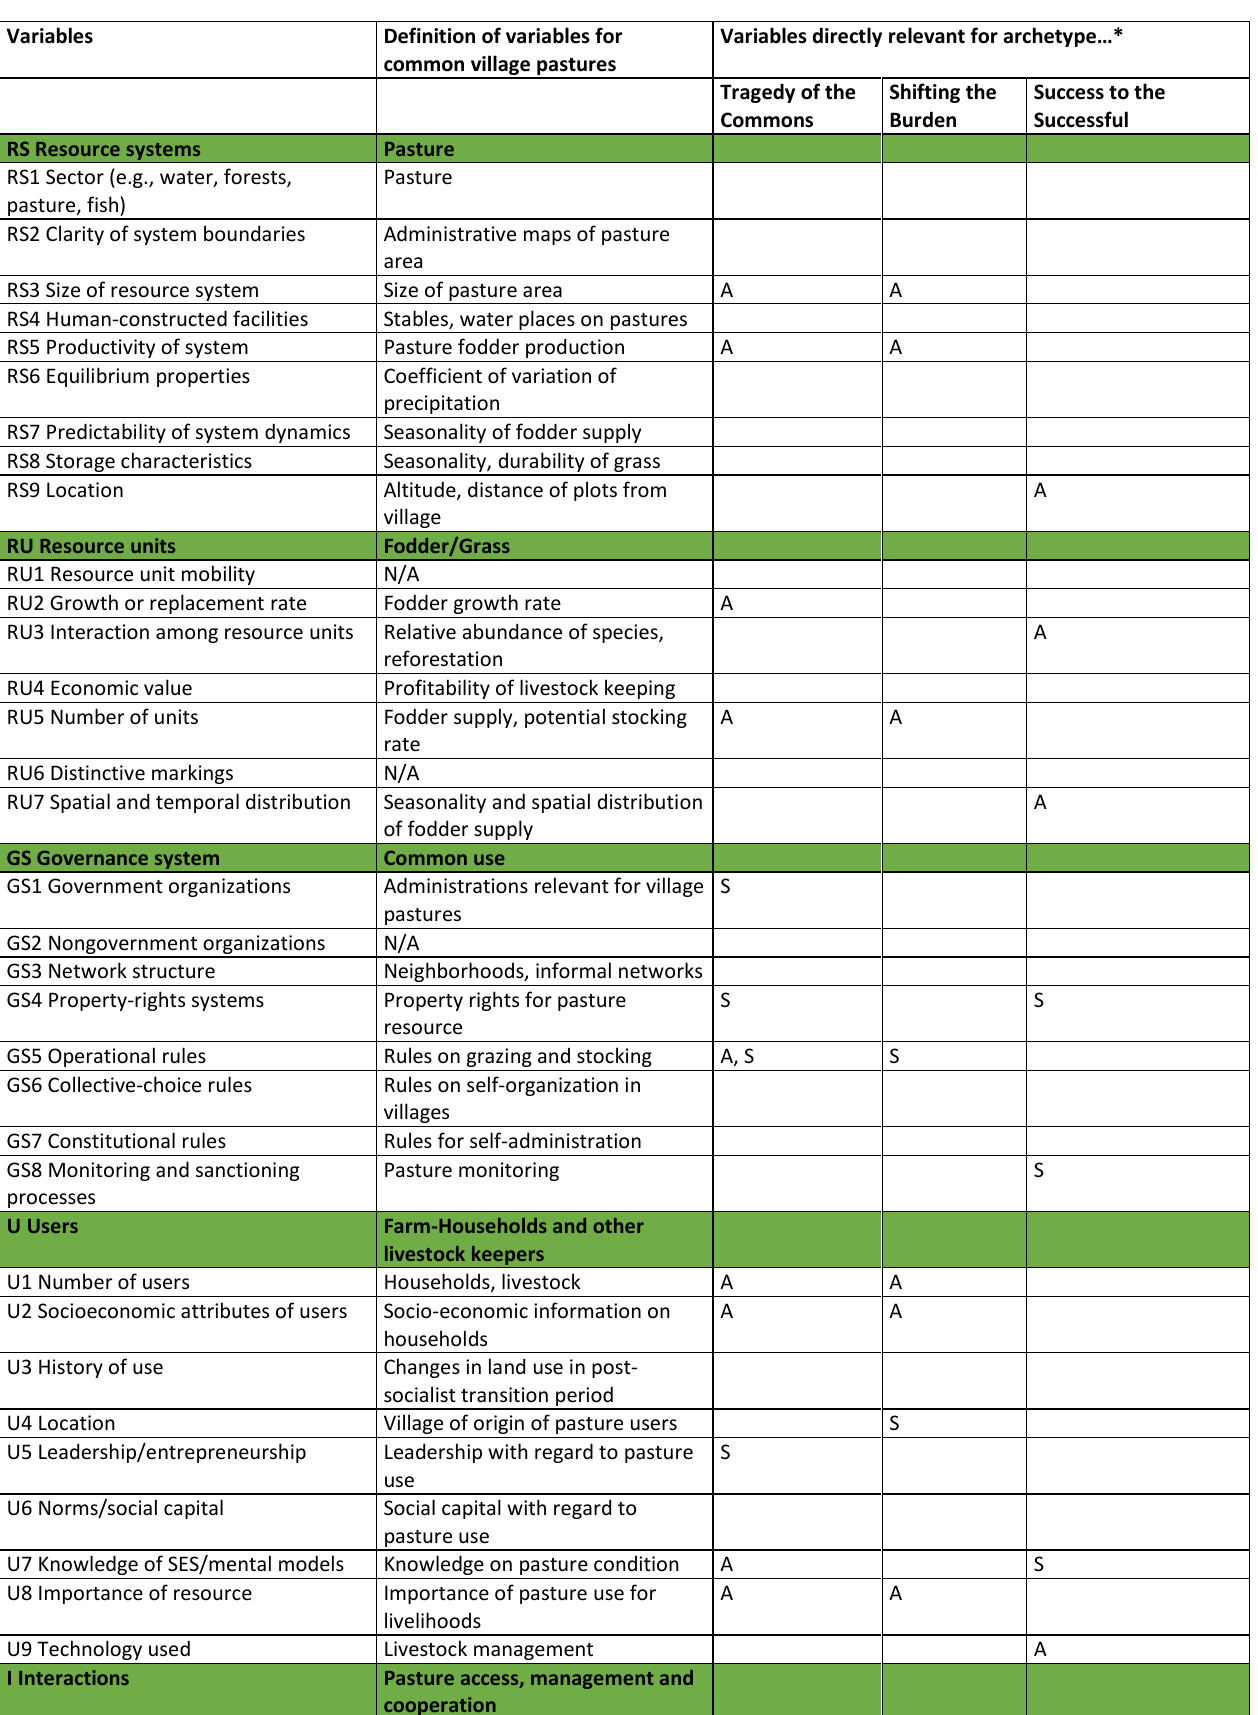
Table A1.1 Variables of the Social-Ecological Systems Framework (after Ostrom 2009) applied to common village pasture